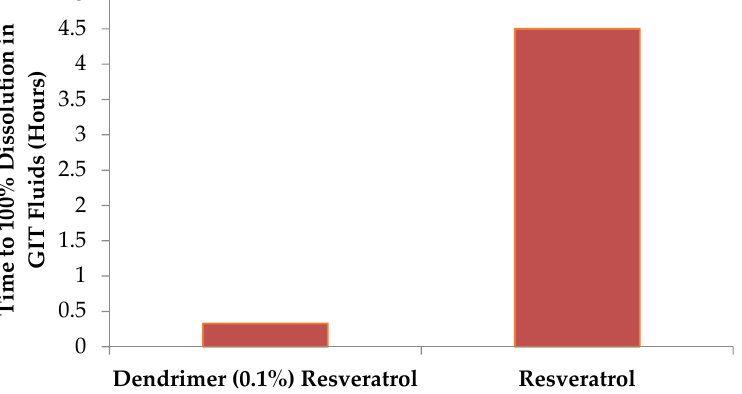
Figure 5. Time taken for RSV formulations to dissolve in GIT and intestinal fluids.